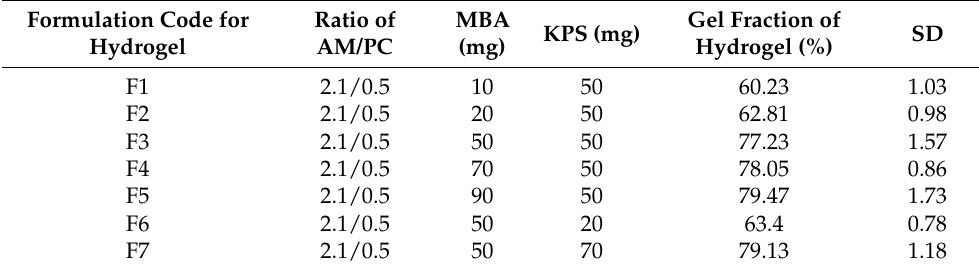
Table 2. Gel fraction of PC/polyacrylamide hydrogel based on different amounts of initiator and cross linker with constant ratio of